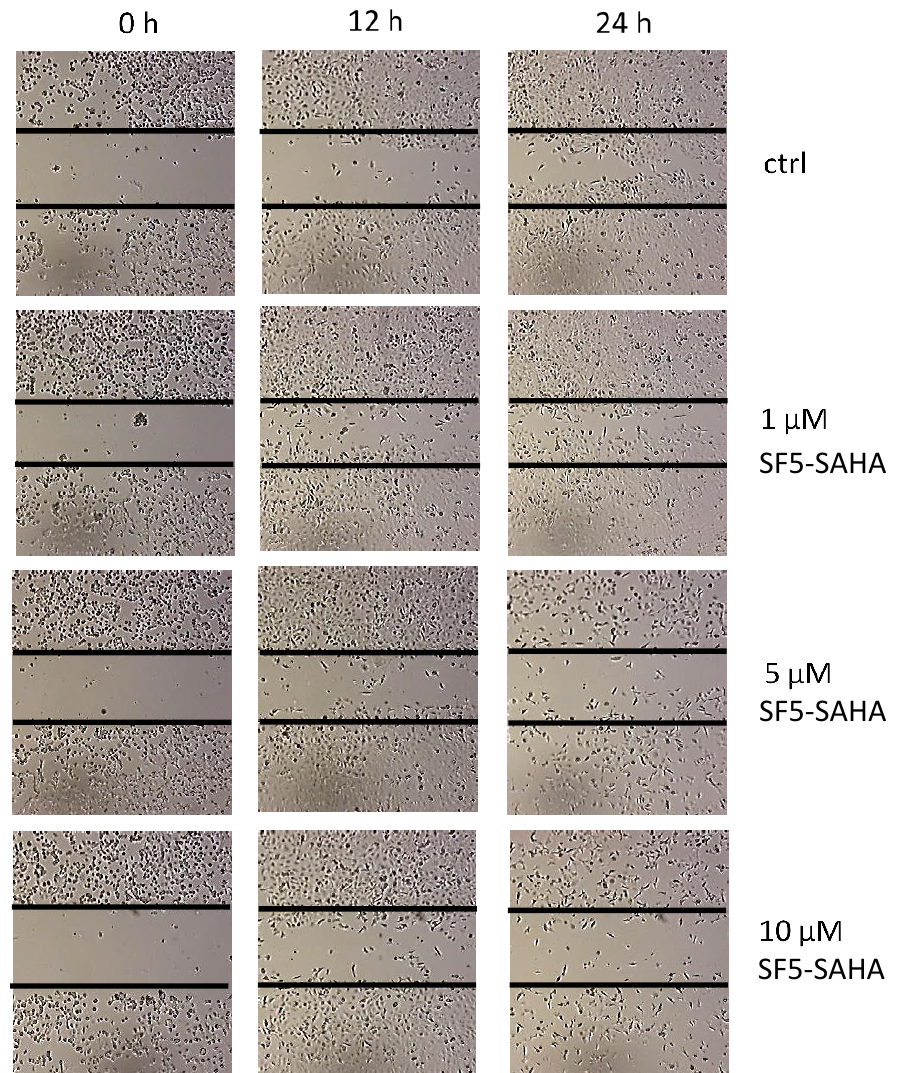
Figure 11. Inhibitory effects of SF5-SAHA on DU145 tumor cell migration. Representative scratch assay images of n = 3 independent experiments showing a treatment induced retarded migration of DU145 cells after 24 h. Black lines indicate the initial scratch areas at the corresponding starting points (0 h). Control cells (ctrl) are untreated cells in medium.